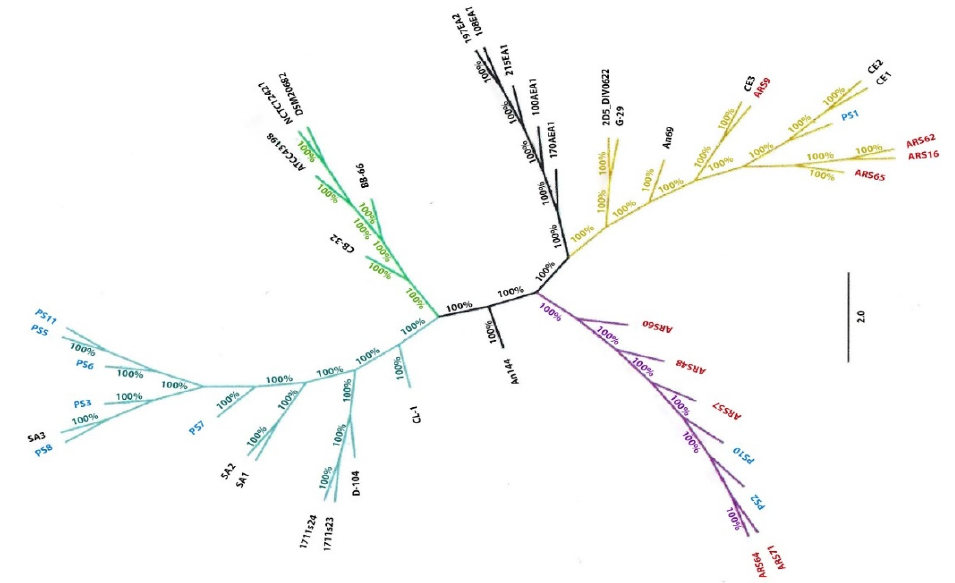
Figure 4. Core genome phylogenetic tree of 42 Enterococcus cecorum strains. The core genome phylogenetic tree was generated using the core-genome of the E. cecorum isolates from this study and 24 E. cecorum genomes from NCBI GenBank. Table 2. List of intact phage in Enterococcus cecorum isolates from healthy and diseased chickens. Isolate